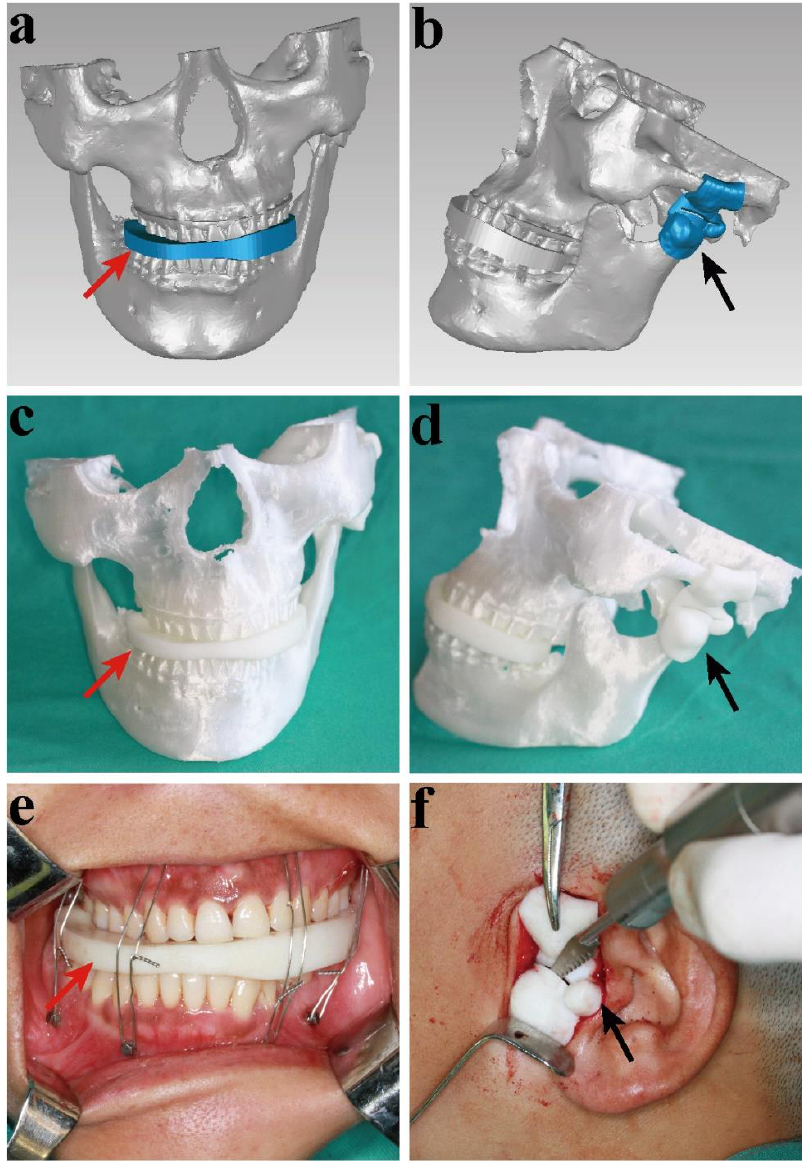
Figure 4. The virtual and 3D-printed models of the surgery: ( a ) The virtual 3D-printed occlusion splint (DOS); ( b ) the virtual 3D-printed osteotomy template (DOT); ( c ) the DOS and 3D-pring models; ( d ) the DOT and 3D-pring models; ( e ) the DOS in surgery; ( f ) the DOT in surgery (red arrow—DOS; black arrow — DOT) .